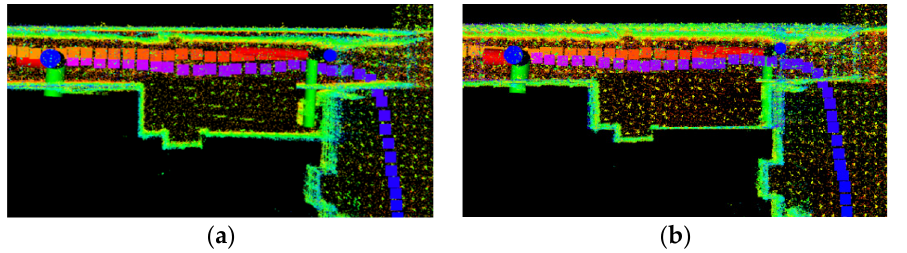
Figure 11. Partial enlarged view of the red boxed section in Figure 9: ( a ) for LeGO-LOAM; and ( b ) for LeGO-LOAM-SM.